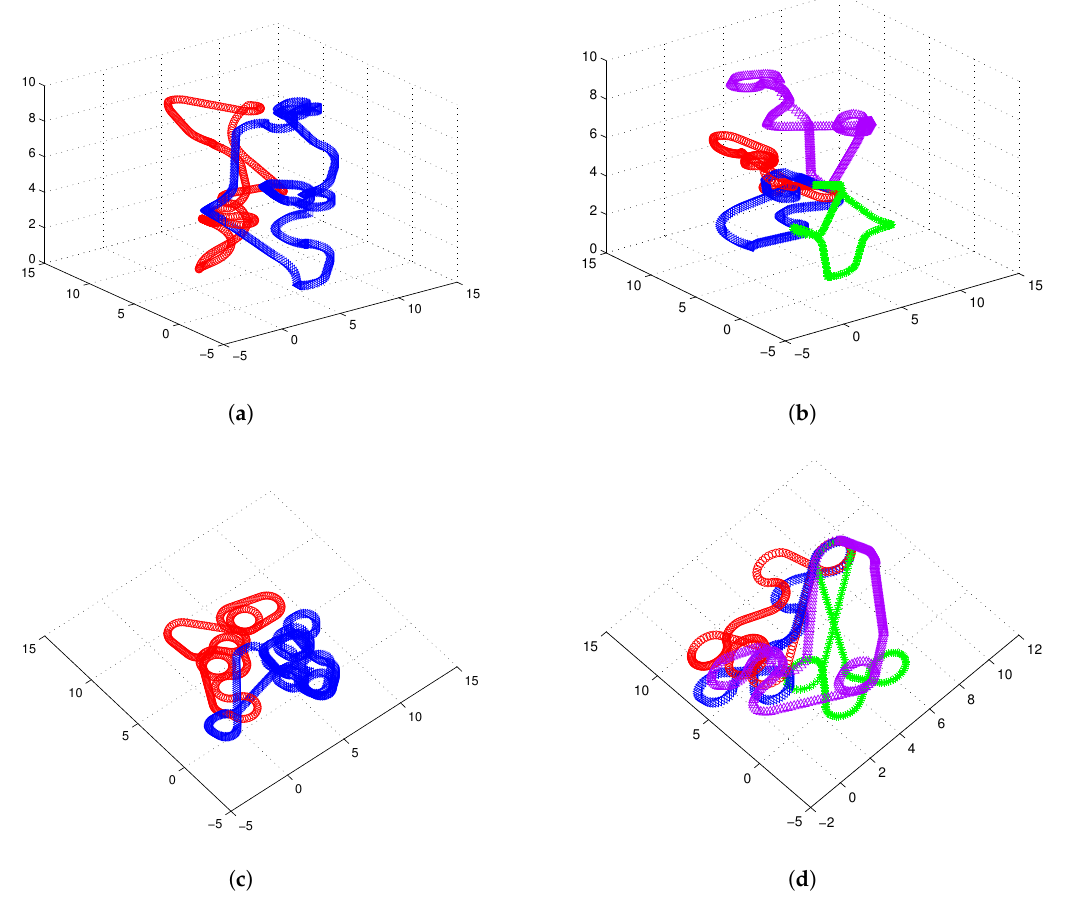
Figure 7. 3D Dubins curves based targets tracking task assignment with 20 targets. Color online. ( a ) 3D Dubins curves with two AUVs; ( b ) 3D Dubins curve with four AUVs; ( c ) 3D Dubins curces projected 2D plane with two AUVs; ( d ) 3D Dubins curves projected 2D plane with four